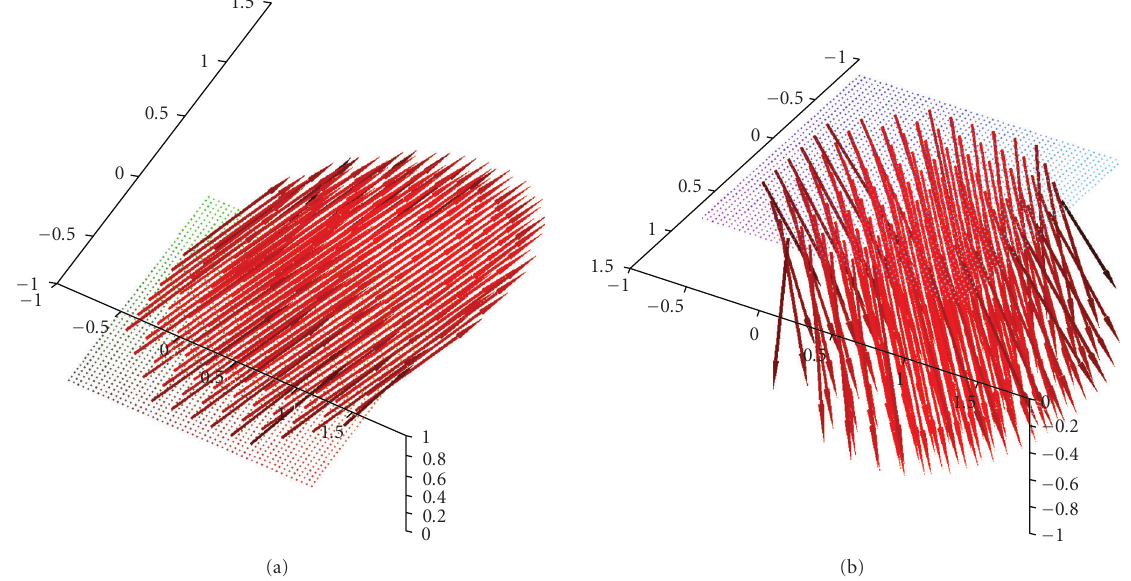
Figure 18: (a) Reconstruction of the vector field f ( x ) = (1,1,1) (cid:9) with the described algorithm for γ = 0 . 007 with circles in the planes { x = 0 } and { x = 0 } . (b) Reconstruction of the vector field f ( x ) = (1,1, − 1) (cid:9) with the described algorithm for γ = 0 . 007 with circles in 3 2 the planes { x 3 = 0 } and { x 2 = 0 } .